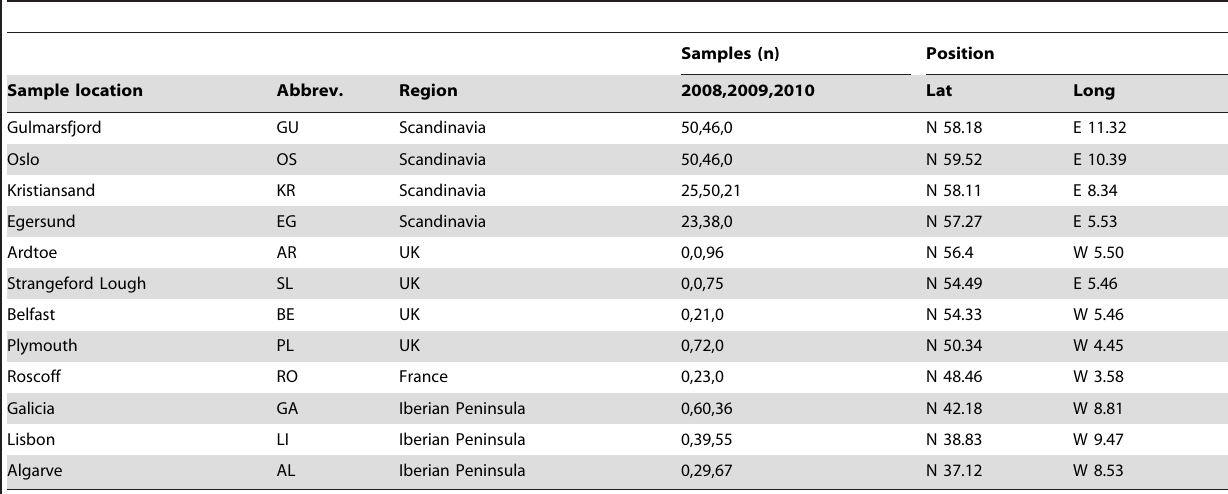
Table 1. Summary information on corkwing wrasse samples, including information on abbreviated names (Abbrev.), sample size for each of the years (2008–2010), and geographical position (Lat=latitude and Long =longitude, in decimal degrees).